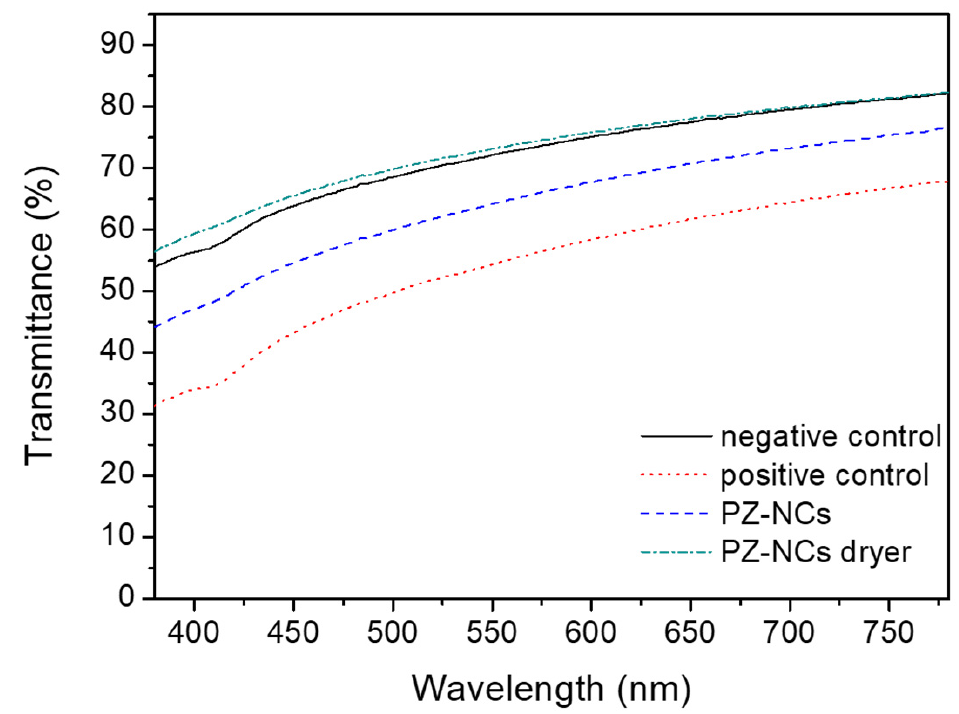
Figure 7. Transmittance values (%) as a function of wavelength in the visible region for the different studied pig corneas.